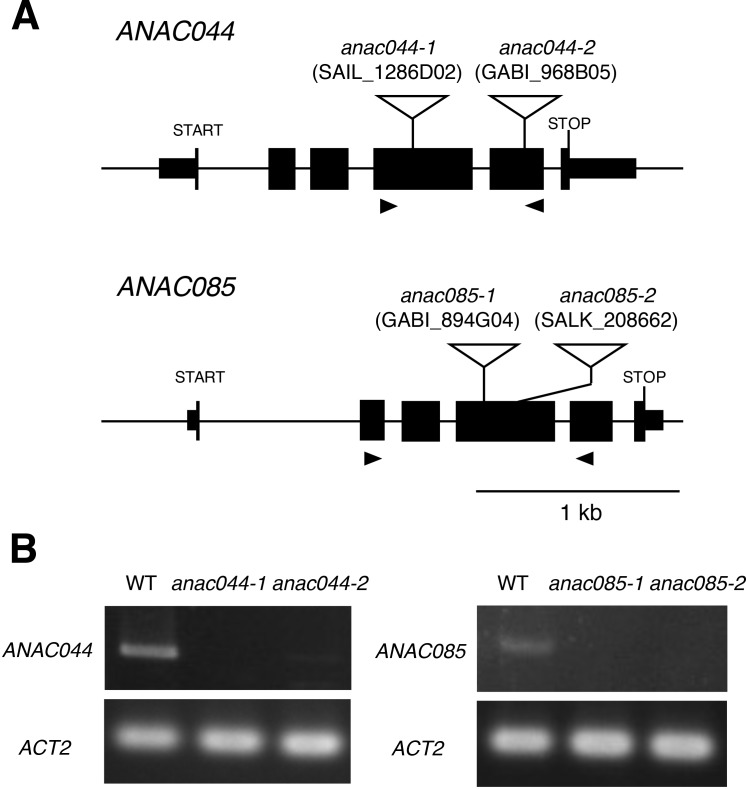
T-DNA insertion mutants of ANAC044 and ANAC085.(A) Schematic representation of the ANAC044 and ANAC085 genes. T-DNA insertion sites in anac044-1, anac044-2, anac085-1 and anac085-2 are shown. Exons and introns are indicated by black boxes and solid lines, respectively. The positions of primers used for RT-PCR are depicted by black triangles. (B) Semi-quantitative RT-PCR analysis of the anac044 and anac085 mutants. Total RNA was extracted from five-day-old seedlings, and subjected to RT-PCR using primers shown in A. ACTIN2 (ACT2) was used as a control.